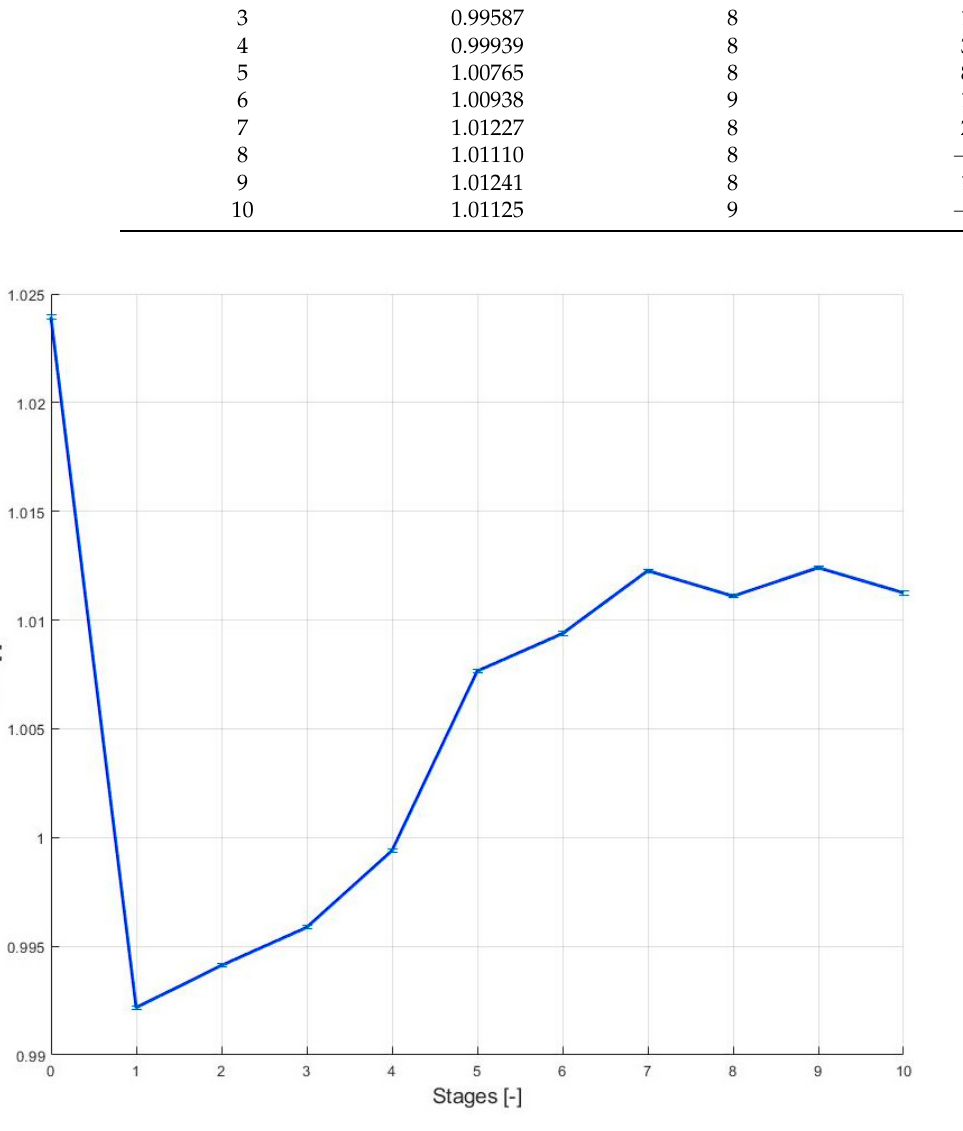
Figure 28. Full core convergence between iterations on Serpent/CTF.